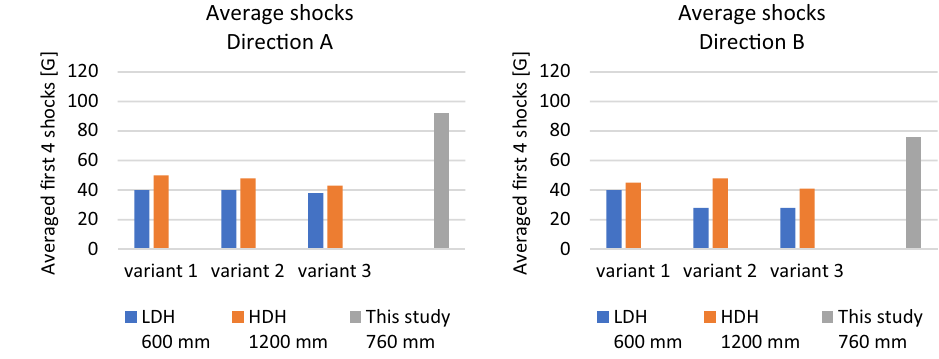
Fig. 17 Comparison of both study